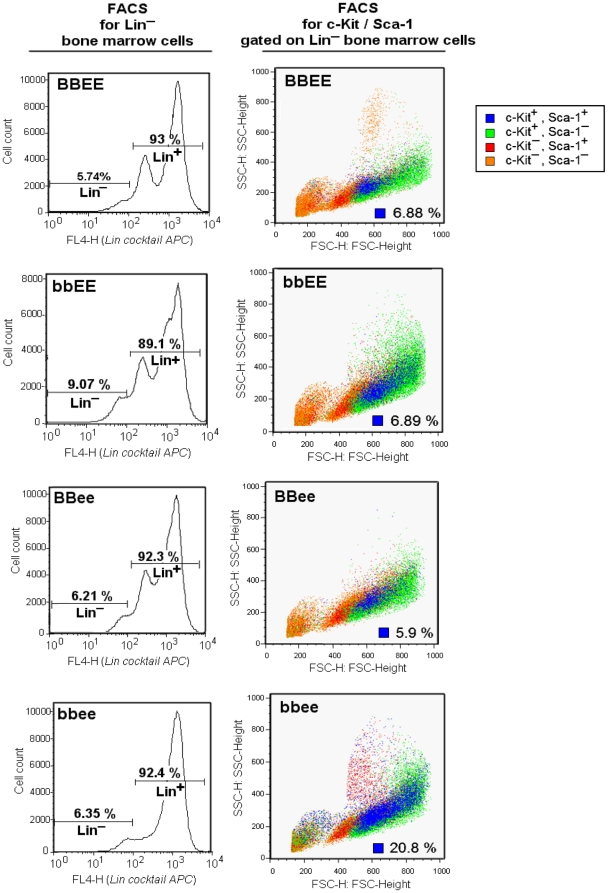
Ratio of hematopoietic progenitor cells.The lineage-negative fraction of bone marrow cells was sorted with FITC-conjugated anti-c-Kit and PE-conjugated anti-Sca-1 antibodies. The hematopoietic progenitor cell population [KSL population (c-Kit+, Sca-1+, and Lineage−; blue dots)] was compared between the wild-type (BBEE), C/EBPβ−/− (bbEE), C/EBPε−/− (BBee) and C/EBPβ−/−C/EBPε−/− (bbee) mice.